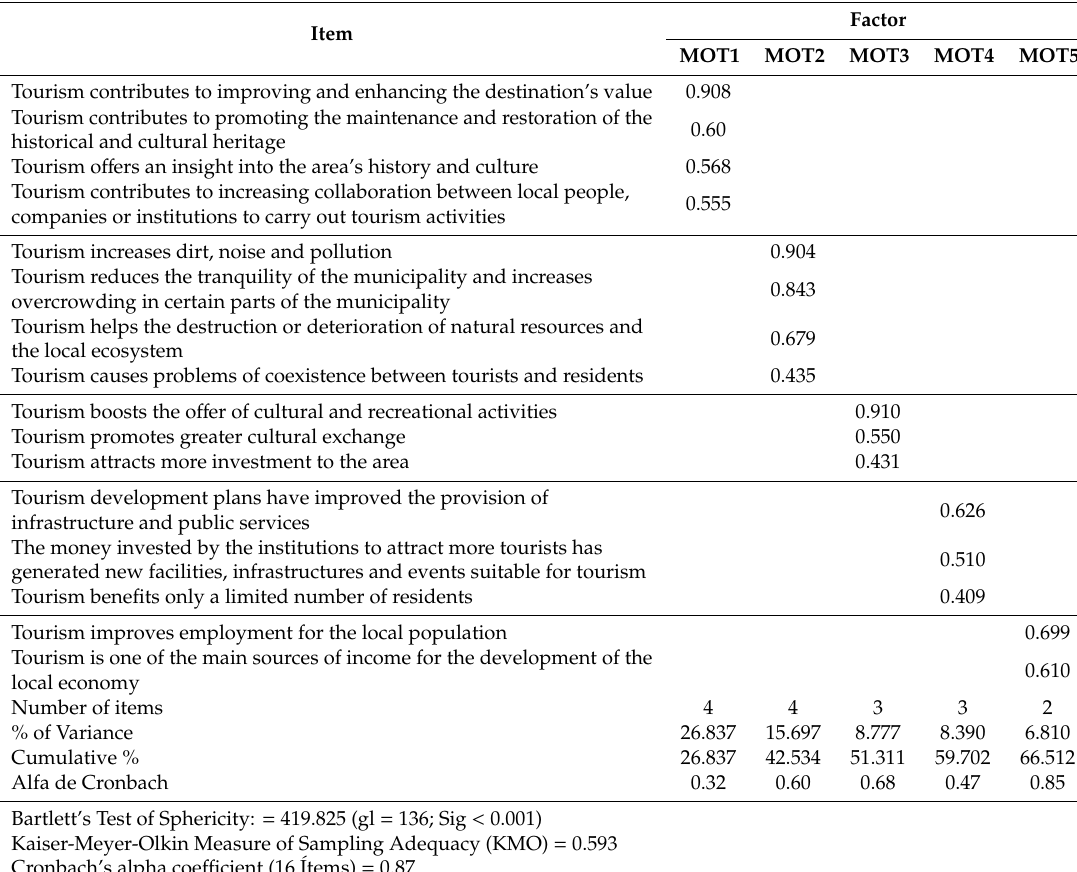
Table 4. Exploratory factor analysis of the variables that measure the di ff erent types of impacts. Source: Author´s own. Item